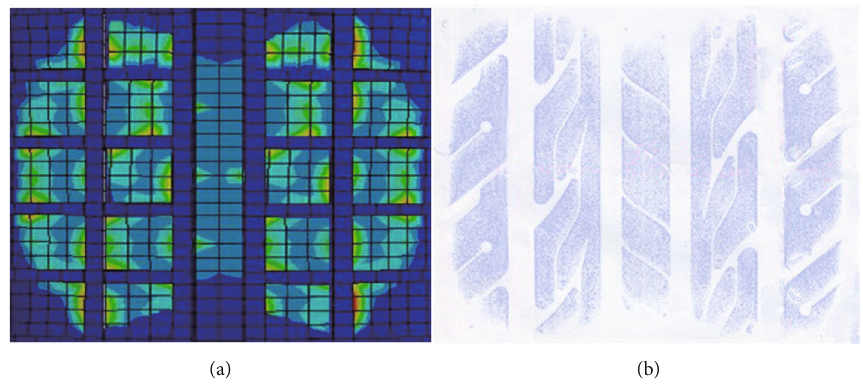
Figure 6: Comparison of tire contact patches. (a) Simulation result and (b) Test result. Table 1: The test and simulation results of contact patch dimensions.